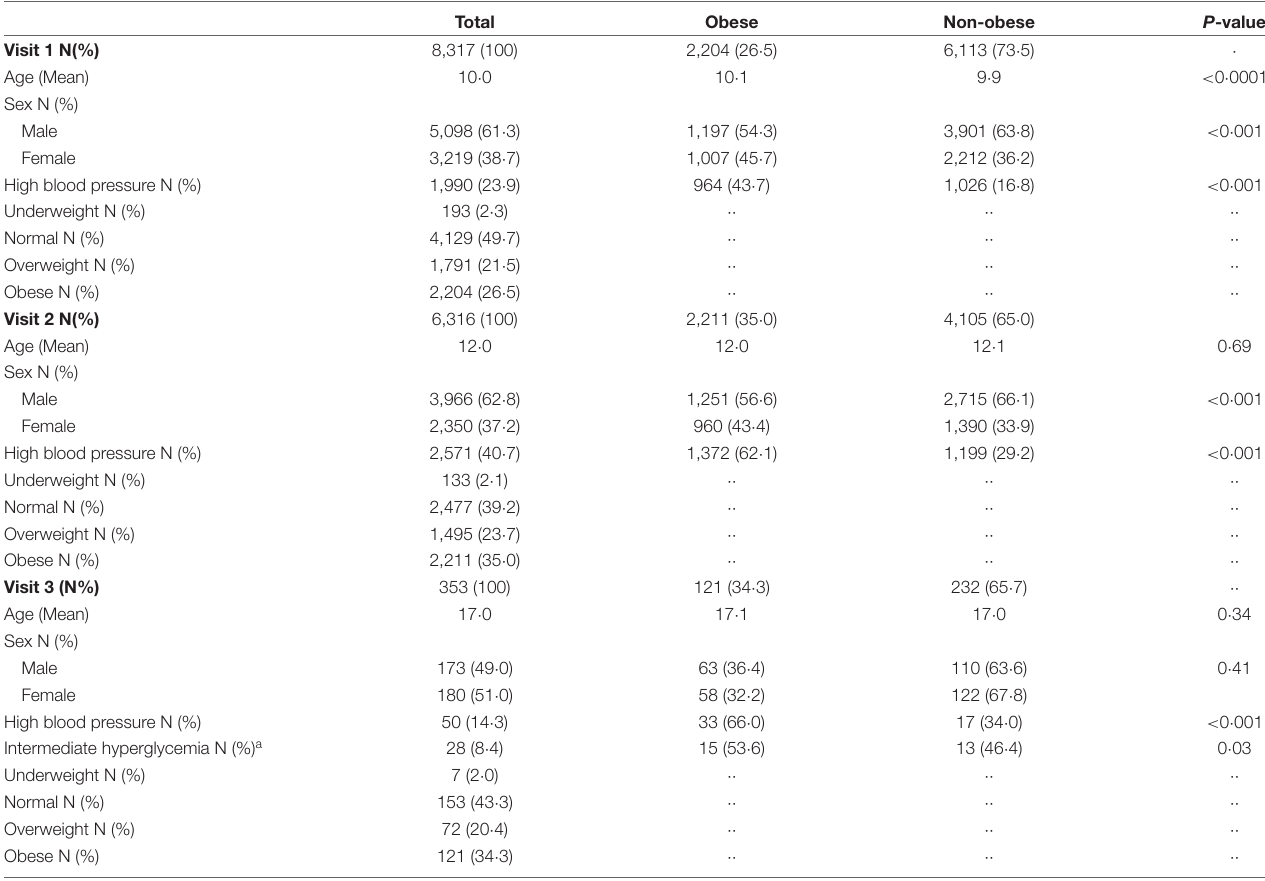
TABLE 2 | Demographics of individuals during the three visits stratified by obese and non-obese using WHO